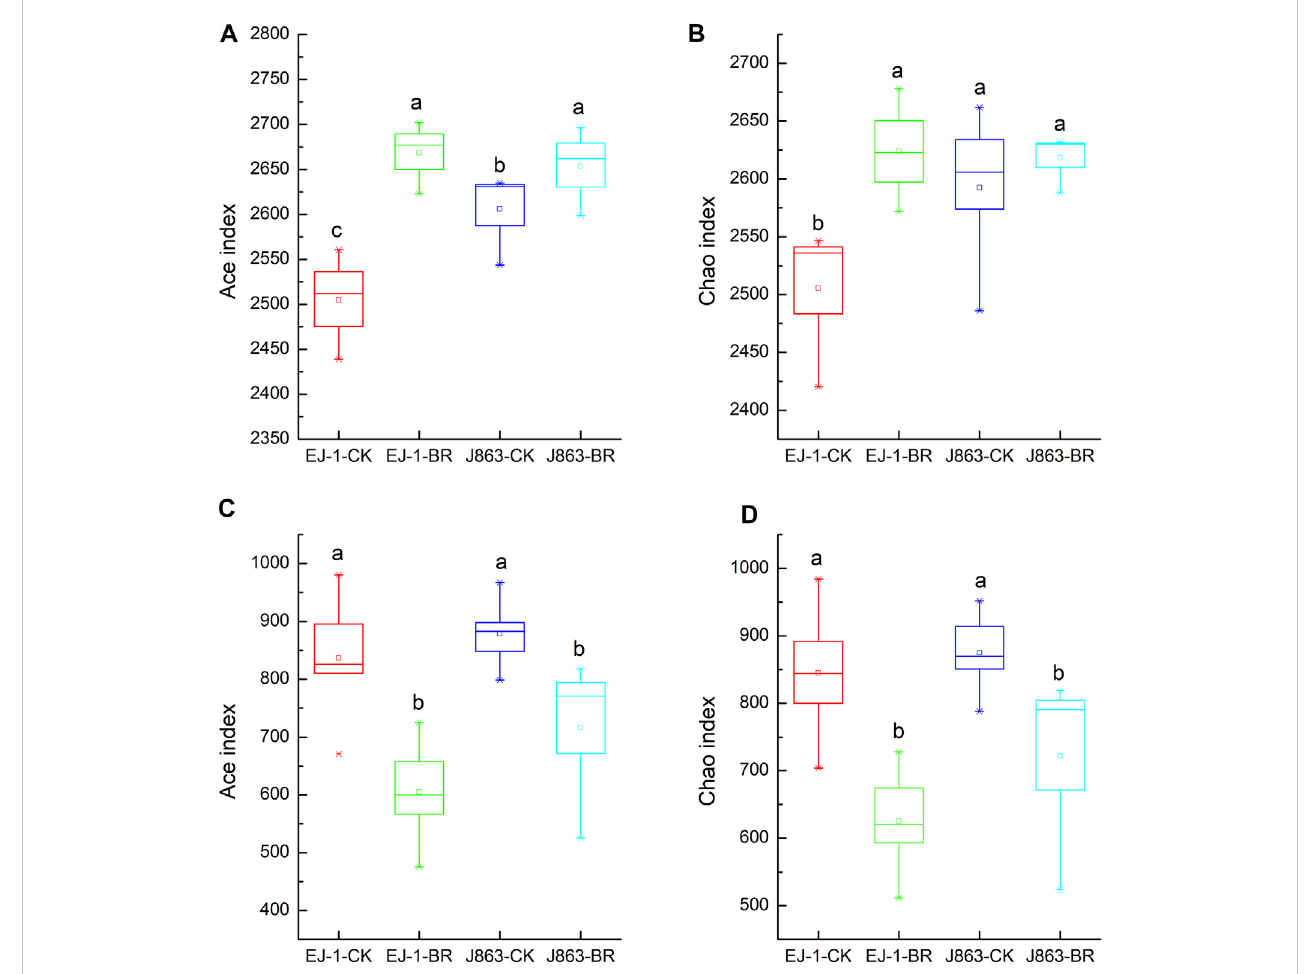
FIGURE 3 Effect of the BR treatment on the alpha diversity indices of soil bacterial and fungal community. (A, B) bacterial, (C, D) fungal. CK represents treatment with blank control, BR represents treatment with broccoli residues. EJ-1 represents susceptible cultivar for CVW, J863 represents resistant cultivar for CVW. Bars with different letters are signi fi cantly different by Duncan ’ s multiple range test at p <